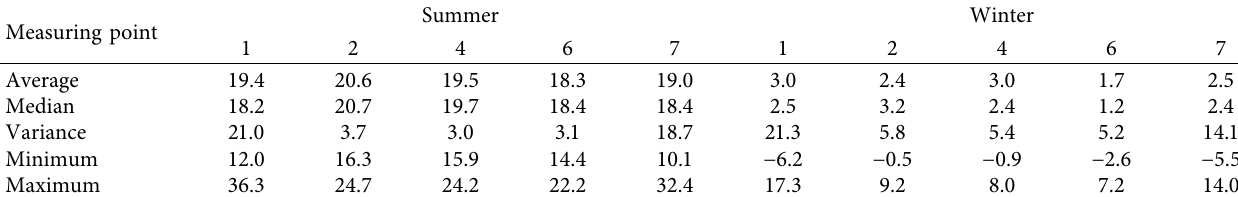
Table 3: Statistical analysis results of temperature data ( °